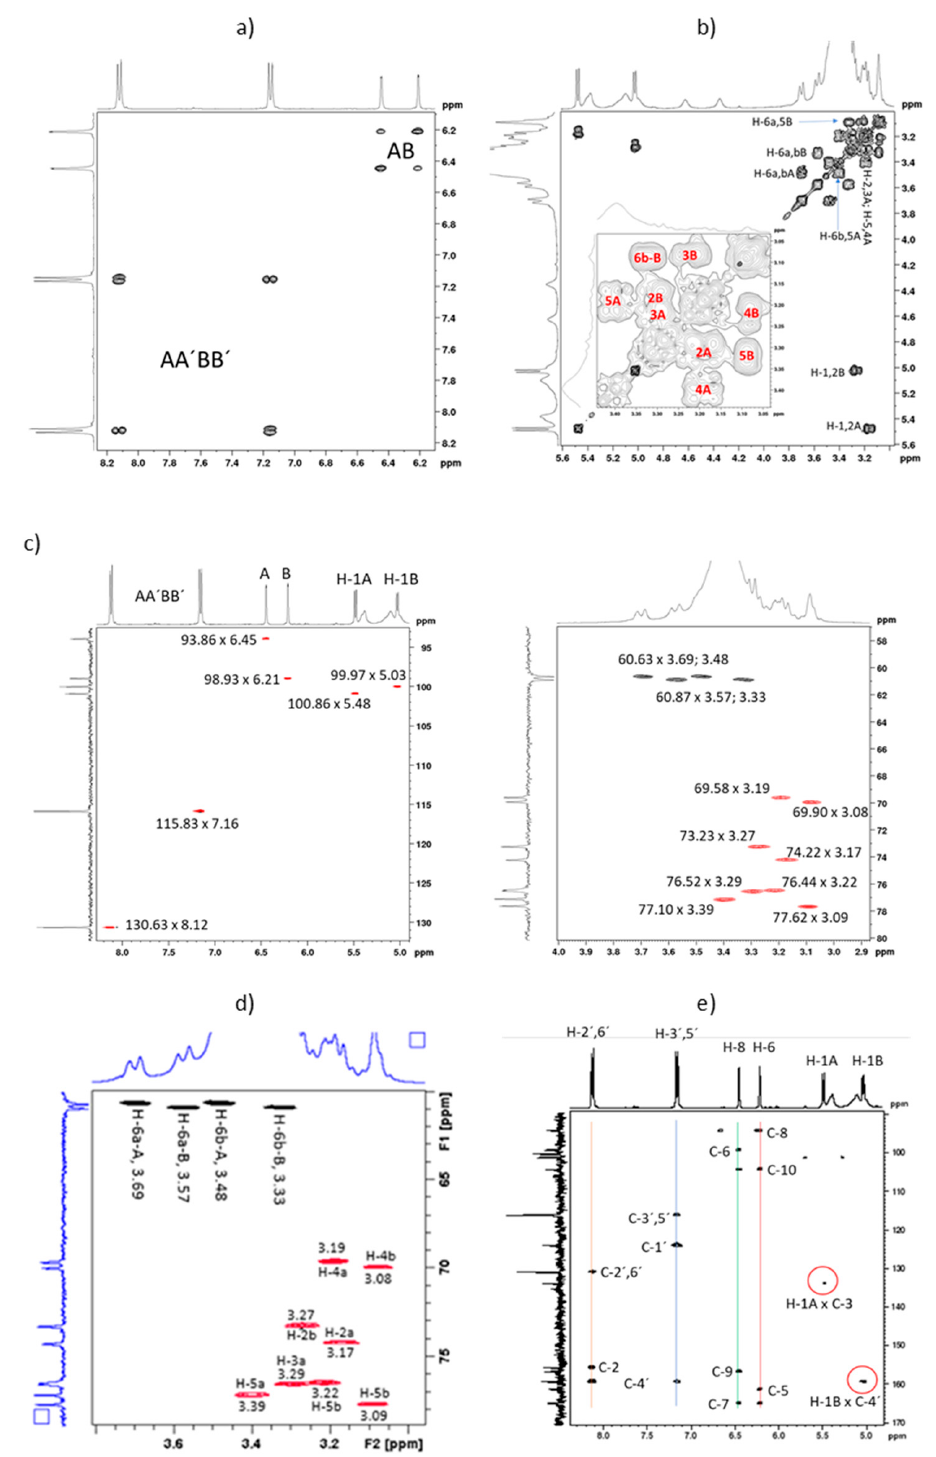
Figure 3. ( a ) COSY expanded contour plot of the aromatic region showing the AA’BB’ and AB coupling systems; ( b ) COSY expanded contour plot of the pyranosidic region; ( c ) HSQC expanded contour plot of the pyranosidic region showing the precise chemical shifts; ( d ) assignments of the pyranosidic unities and ( e ) HMBC expanded contour plot showing the kaempferol 3 and 4 ′ glucosilated positions.